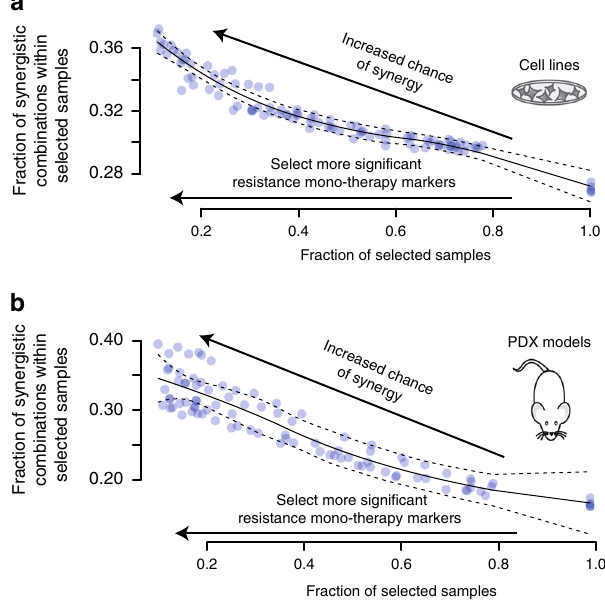
Fig. 6 Drug synergy and monotherapy resistance biomarker relationship. a Cell lines and b PDX models show increased frequency of synergistic drug combinations if they contain biomarkers with stronger association to monotherapy resistance (Methods; Supplementary Methods). The fraction of combination experiments is selected by order of most signi fi cant linked monotherapy resistance biomarker associations. The solid and dashed line are the LOcal regrESSion (LOESS) curve fi t and its standard error,